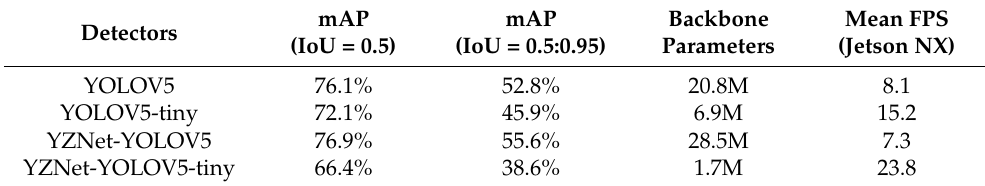
Table 3. The performance indexes for YZNet against